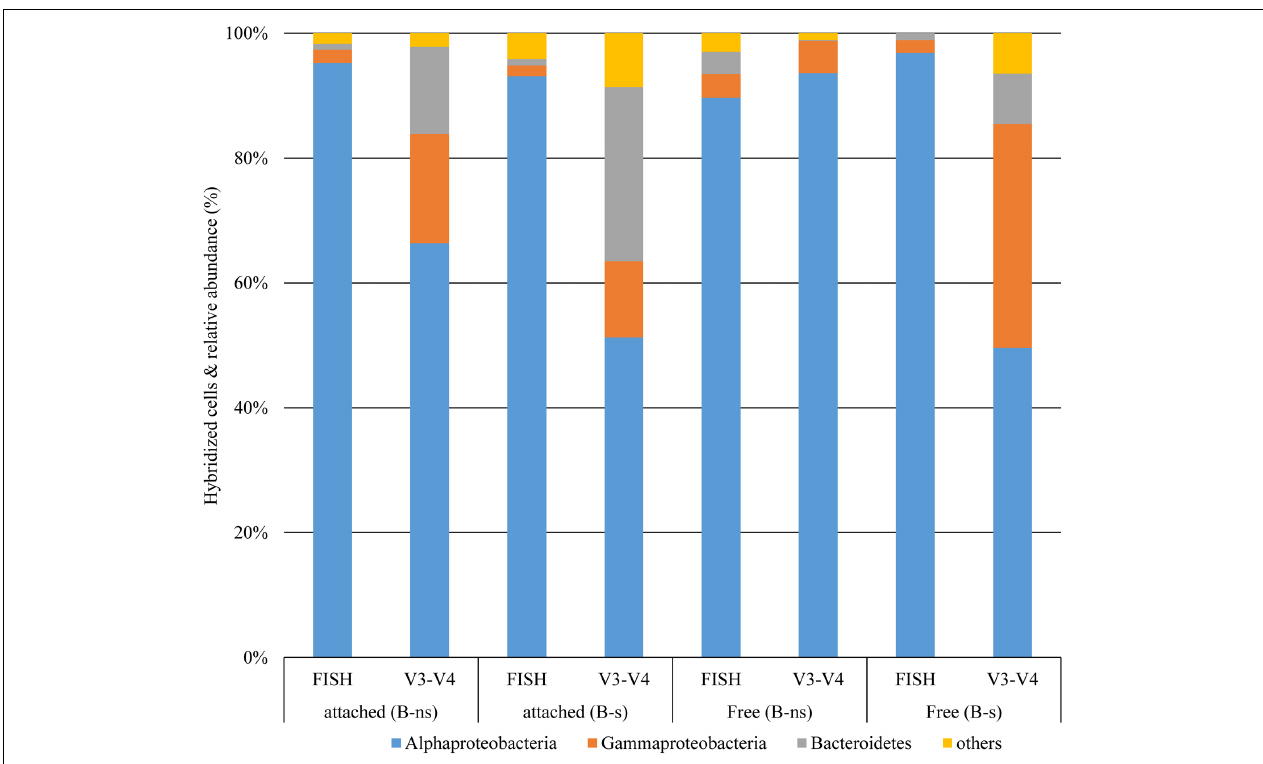
FIGURE 6 | Comparison of taxonomic classification of bacterial groups at phylum and class levels from 16 rDNA-FISH hybridization and 16S rDNA (V3–V4) Illumina